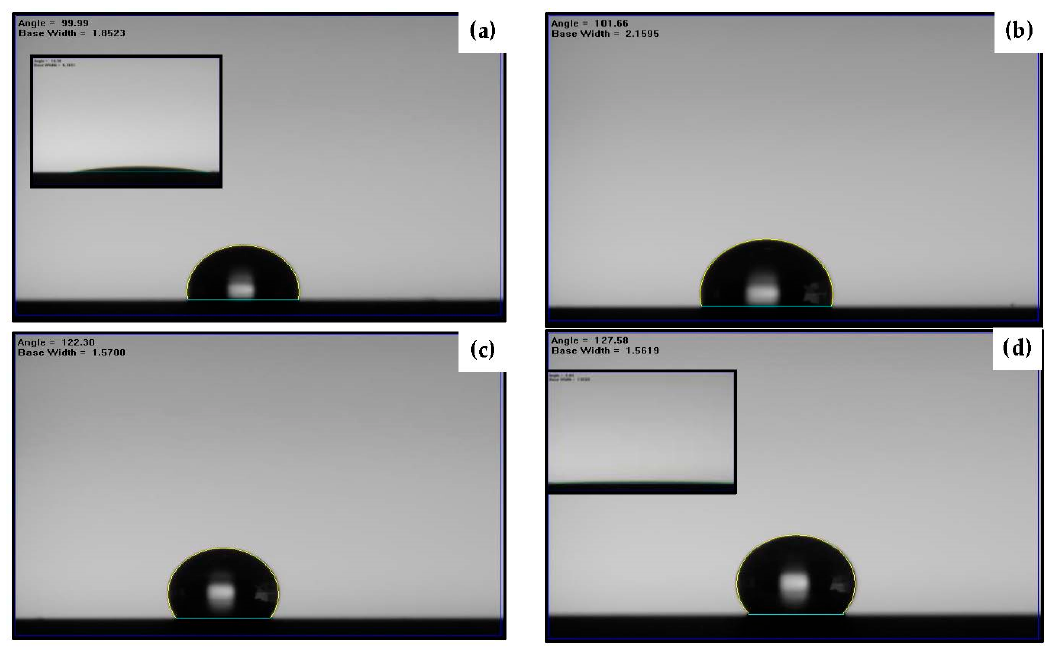
Table 2. Surface roughness, water contact angle, and oleic contact angle of the organosilicon film directly deposited onto the silicon substrate and deposited onto the as-deposited and annealed Ag seed layer.